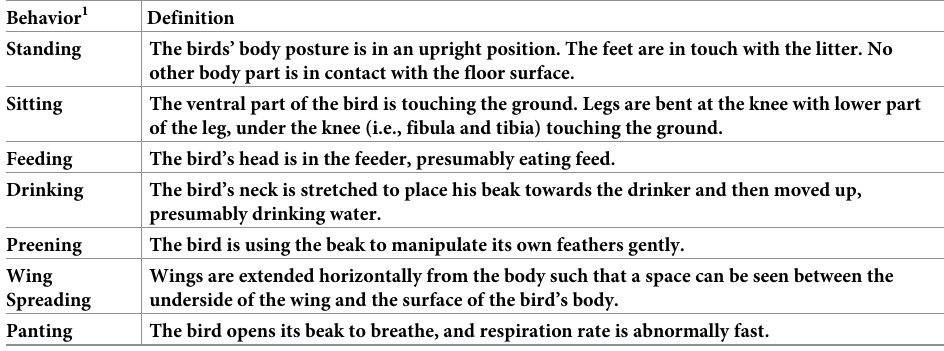
Table 2. Ethogram of broiler behaviors according to Mohammed et al.